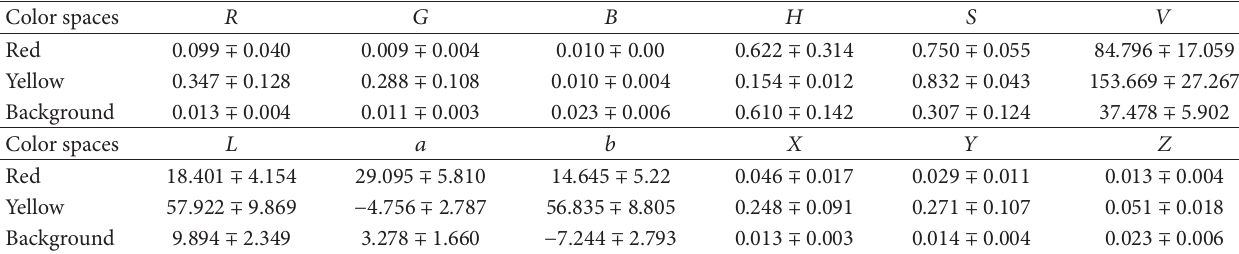
Table 1: Experimental results of different color spaces for apples.